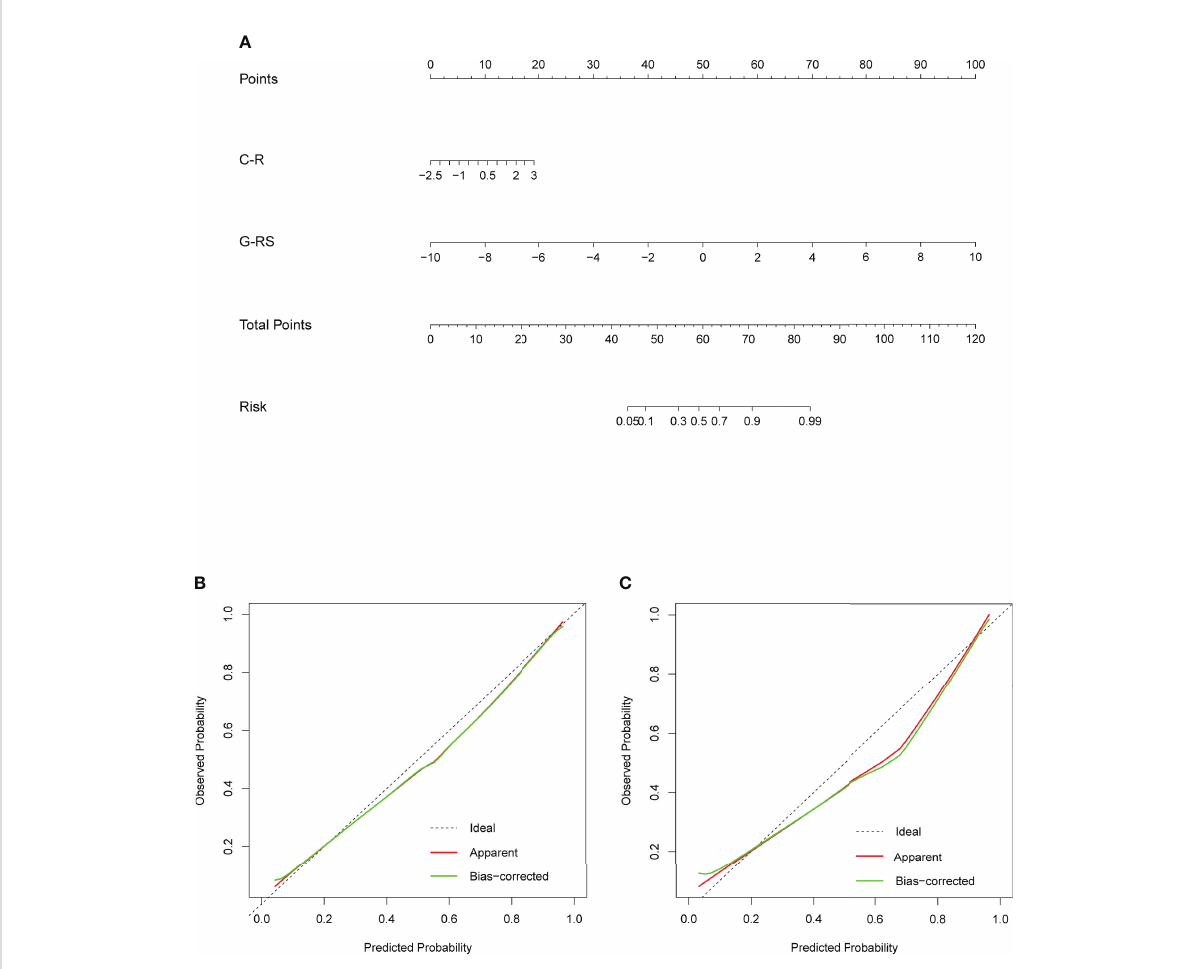
FIGURE 7 (A) Nomogram based on clinical radiology and gross radiomics. Calibration curves of the nomogram in the training (B) and validation (C) sets; the x-axis indicates the predicted probability estimated by the nomogram, while the y-axis indicates the actual probability. Apparent probabilities and bias-corrected probabilities are indicated by red and green solid lines,